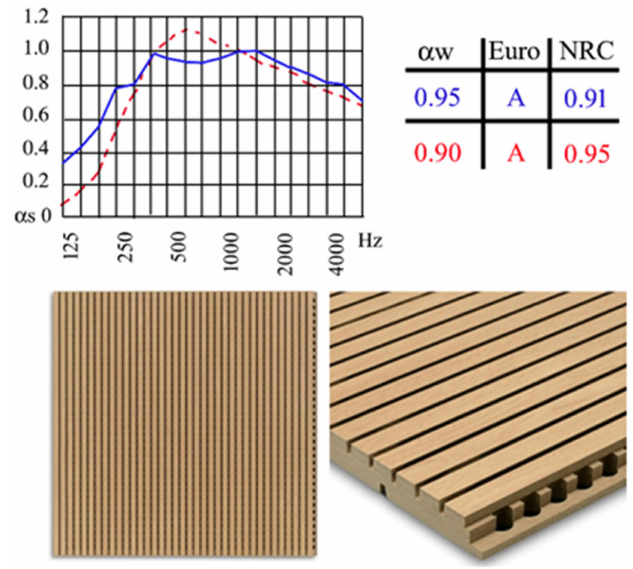
Figure 5. Sound absorbing and reflective panel